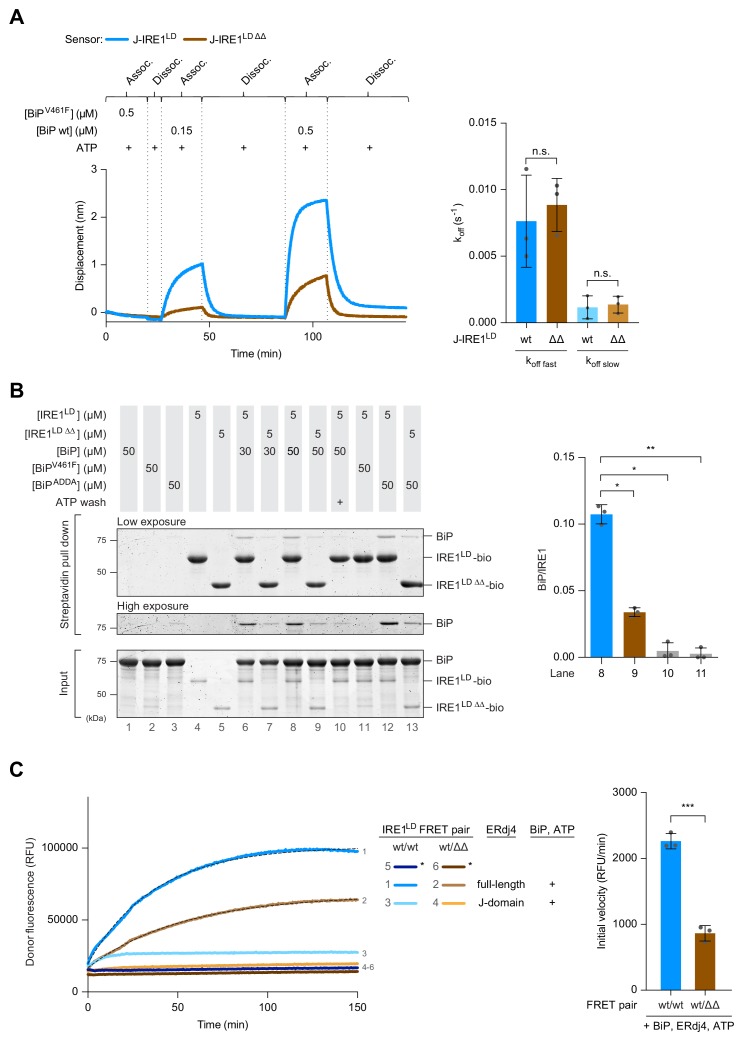
Impaired BiP binding and monomerisation of IRE1LD ΔΔ in vitro.(A) Left panel shows Bio-Layer Interferometry (BLI)-derived association (assoc.) and dissociation (dissoc.) traces of streptavidin sensors loaded with the indicated biotinylated ligands [a fusion of ERdj4’s J-domain to IRE1LD wild-type (wt) or ∆∆, as in Figure 1D] and exposed sequentially to the indicated solutions of analyte (containing wt BiP or the client-binding mutant BiPV461F). A representative experiment of three independent repetitions is shown. The traces were subtracted against a background derived from a BLI sensor with no ligand and the BLI signals (displacement) were set to zero after the first washing step. Quantification of the dissociation rate constants koff after association in presence of 0.15 µM BiP and 2 mM ATP are shown to the right. Traces were fitted to a two-phase dissociation function in Prism GraphPad 7.0. Shown are the mean ± standard deviation (SD) of three independent repetitions (n.s.: not significant, unpaired parametric Student’s t test). (B) Coomassie-stained SDS-PAGE gel of biotinylated wt IRE1LD (IRE1LD-bio), double deleted IRE1LD ∆∆ (IRE1LD ∆∆-bio) and BiP, recovered on a streptavidin matrix from samples constituted as indicated. 2 mM ATP was used during wash steps of the matrix when indicated. A representative data set is shown. Quantification of the ratio of BiP to IRE1 signals in the relevant samples after pull down from three independent experiments is shown on the right (mean ± SD, *: p<0.05, **: p<0.01, one-way ANOVA with Sidak’s multiple comparison test). (C) Time-dependent change in donor fluorescence of the indicated IRE1LD FRET pair incubated at t = 0 with the components shown to the right. The asterisks mark samples set up with a mock FRET sensor lacking the IRE1LD donor-labelled molecule. Protein concentrations were 0.2 µM FRET pair, 30 µM BiP, 2.5 µM full-length ERdj4 (or its isolated J-domain) and 2 mM ATP. A representative experiment of three independent repetitions is shown. When indicated, the data points were fitted to a one-phase association function in Prism GraphPad 7.0; the initial velocity represents the slope of the curve at time point zero (mean ± SD, ***: p<0.001, unpaired parametric Student’s t test) (see: Figure 5—source data 1).Figure 5—source data 1.Source data for Figure 5A.Figure 5—source data 2.Source data for Figure 5C.